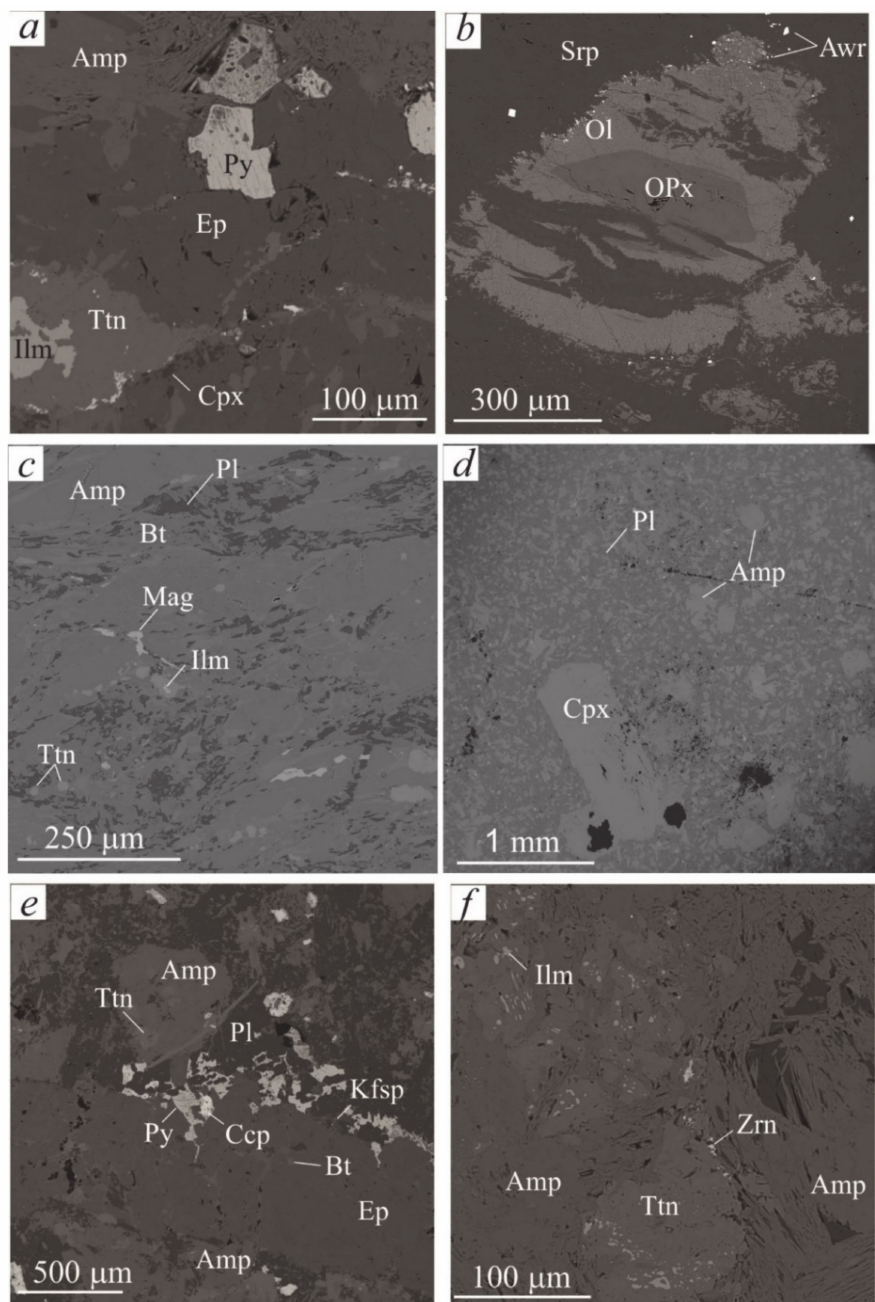
Figure 6. Back scattered electron (BSE) microphotographs of the cumulate rocks and mafic rocks associated with ophiolite: ( a ) Amphibolized pyroxenite with relicts clinopyroxene and plagioclase replaced by epidote; ( b ) olivine-bearing amphibolized pyroxenite–olivine phenocrysts with orthopyroxene inclusion in an olivine-amphibole-talc-serpentine matrix; ( c ) medium-grained amphibolized gabbro with equigranular texture; ( d ) amphibolized gabbro with porphyritic texture; ( e ) monzogabbro with veinlets of pyrite-chalcopyrite; and ( f ) amphibolized gabbro-diabase dike with accessory ilmenite, secondary titanite, and new-formed zircon. Abbreviations: